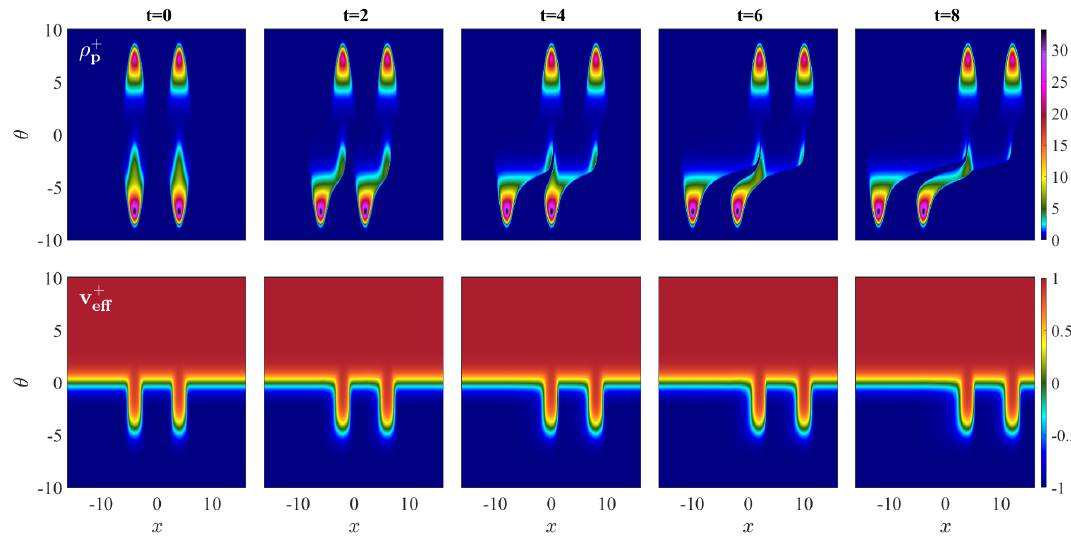
Figure 15 . Spectral density of particle + (row 1) and its effective velocity (row 2) for t = 0 to 8 for a double Gaussian profile (5.2). The parameters are chosen here are α x 0 = 4 . The main new feature is that for t ≥ x 0 the left magnet for particle ( − ) drags some of the particles from the left interacting peak of particle ( + ) into its left subsidiary peak. The later times evolution can be seen in figure